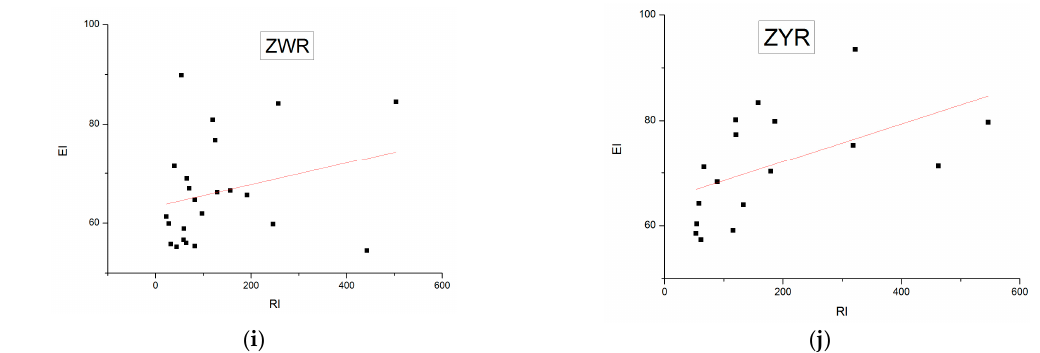
Figure 3. ( a ) Correlation between eutrophication in water bodies and potential risk of heavy metals in sediments in BSR Basin; ( b ) Correlation between eutrophication in water bodies and potential risk of heavy metals in sediments in DPBSR Basin; ( c ) Correlation between eutrophication in water bodies and potential risk of heavy metals in sediments in DQR Basin; ( d ) Correlation between eutrophication in water bodies and potential risk of heavy metals in sediments in HLG Basin; ( e ) Correlation between eutrophication in water bodies and potential risk of heavy metals in sediments in HRB Basin; ( f ) Correlation between eutrophication in water bodies and potential risk of heavy metals in sediments in LR Basin; ( g ) Correlation between eutrophication in water bodies and potential risk of heavy metals in sediments in THMJR Basin; ( h ) Correlation between eutrophication in water bodies and potential risk of heavy metals in sediments in YDRMA Basin; ( i ) Correlation between eutrophication in water bodies and potential risk of heavy metals in sediments in ZWR Basin; ( j ) Correlation between eutrophication in water bodies and potential risk of heavy metals in sediments in ZYR Basin.